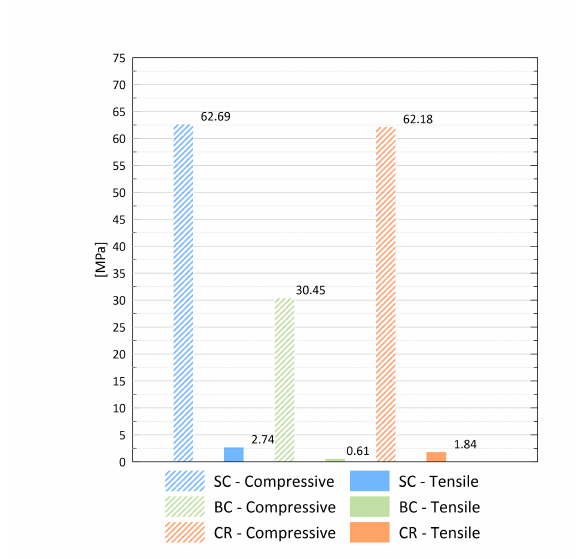
Figure 7. Compressive strength and tensile strength in